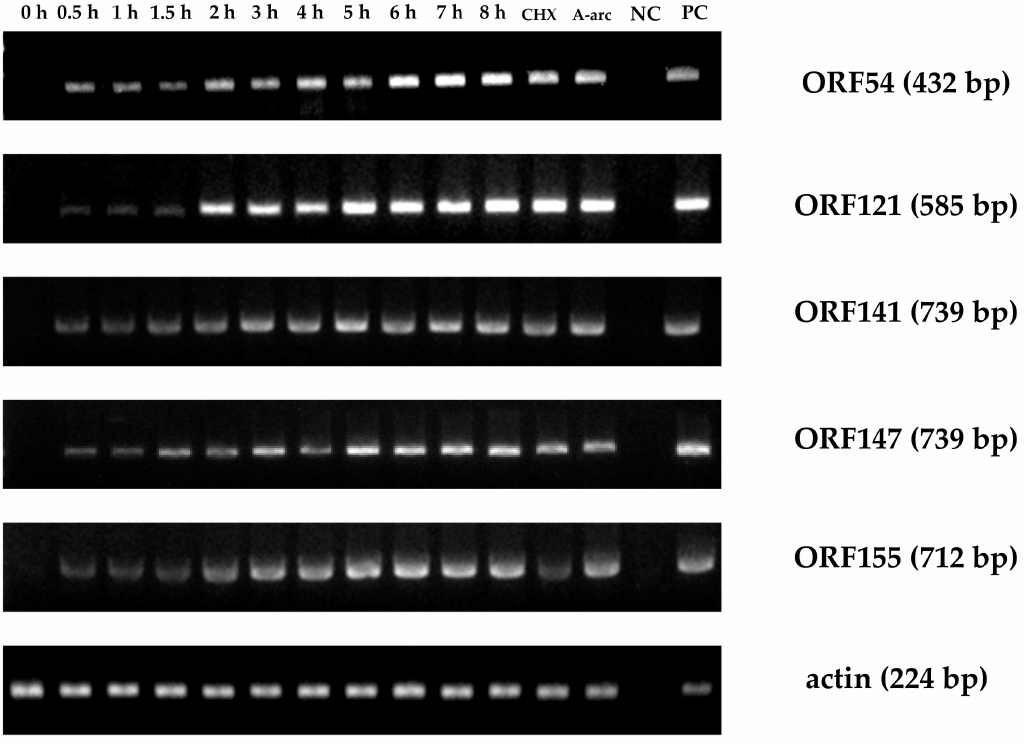
Figure 8. Time course of immediate-early (IE) gene expression during viral infection. At various timepoints, total RNA was extracted from CyHV-2-infected RyuF-2 cells. RT-PCR was used to detect the expression of control genes and all six IE genes. CHX: treated with 12 µ g / mL CHX; Ara-C: treated with 300 µ g / mL Ara-C; NC: uninfected cells; PC: Positive control comprising CyHV-2